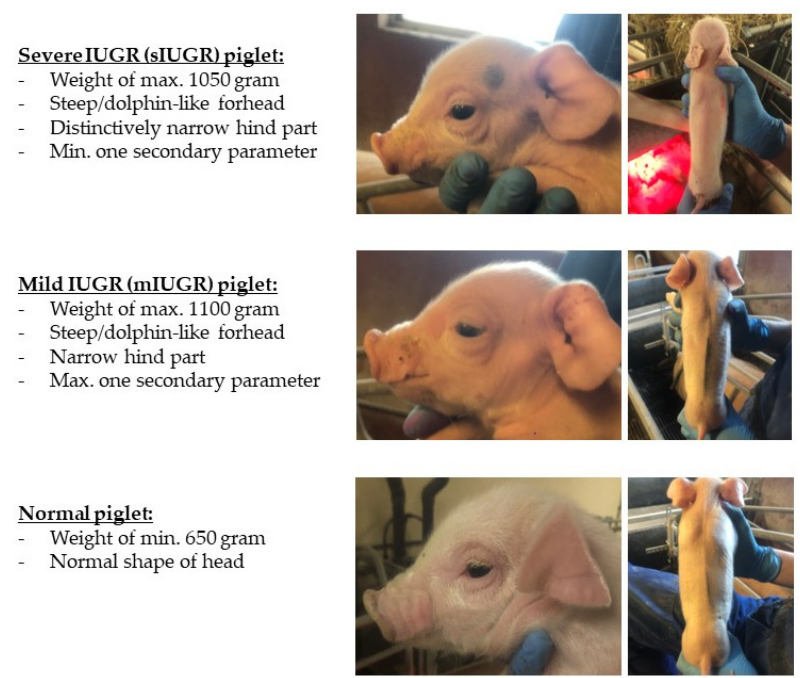
Figure 1. Definition of severe intrauterine growth restriction (sIUGR), mild intrauterine growth restriction (mIUGR), and normal piglets.